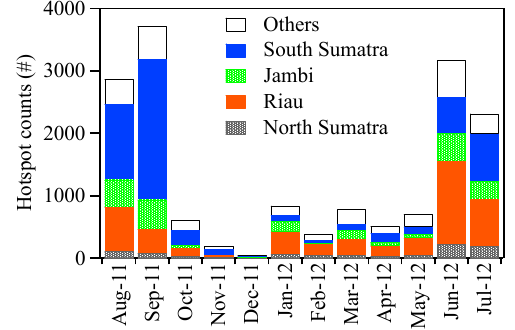
Figure 2. Monthly hotspot counts in the Sumatra